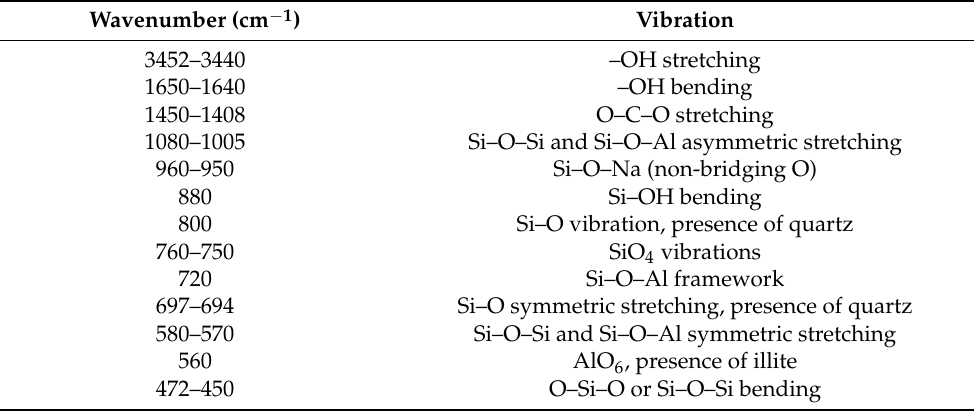
Table 1. FT-IR interpretation table peaks.